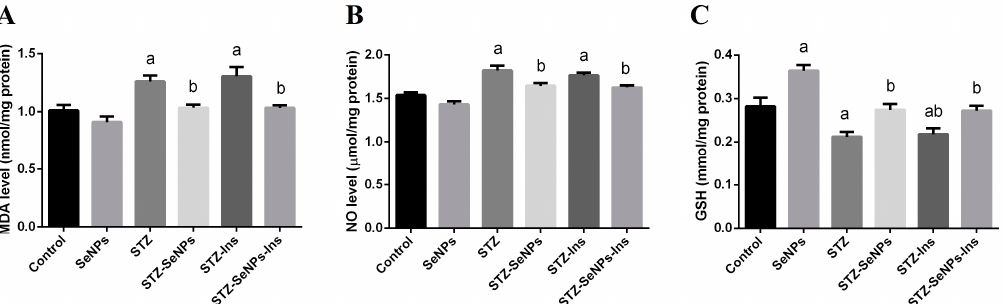
Figure 3. Impact of SeNPs and insulin on oxidative stress markers [( A ) lipid peroxidation: LPO, indicated by MDA; ( B ) nitric oxide: NO and ( C ) glutathione: GSH] in the testis of control and STZ-diabetic rats. Values are mean ± SEM ( n = 7). a p < 0.05, significant change with respect to Control group; b p < 0.05, significant change with respect to Diabetic group.